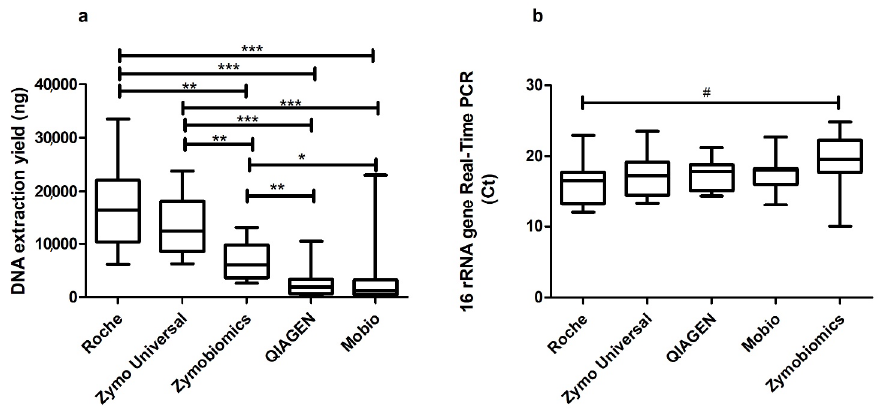
Figure 3. Comparison of median levels of ( a ) DNA extraction yield and ( b ) bacterial extraction efficiency across the five analyzed commercial kits. Kruskal–Wallis test: DNA extraction p < 0.0001; 16s rRNA gene real-time PCR p = 0.169. Mann–Whitney test: *: p ≤ 0.001; **: p ≤ 0.0009, *** p ≤ 0.0001; #: p = 0.027 (Experiment 3).